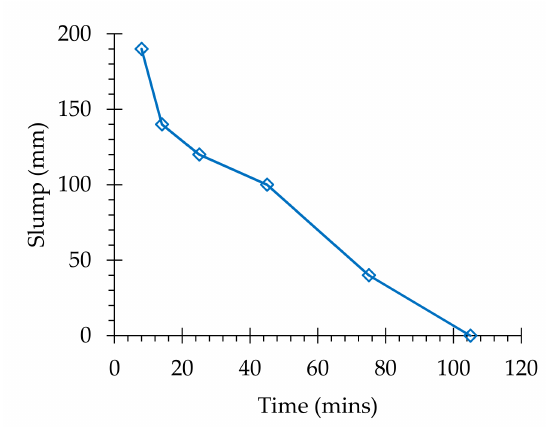
Figure 4. Slump of 15P65 over